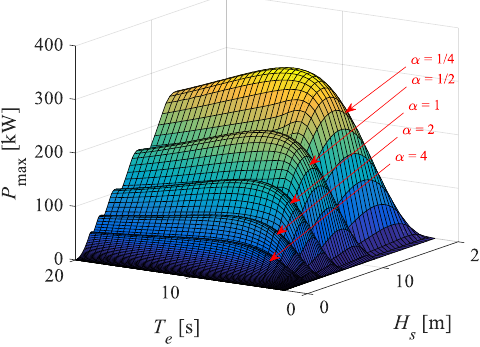
Figure 9. The maximum absorbed power P max as a function of the significant wave height H s and energy period T e at different radius-to-draft ratios.